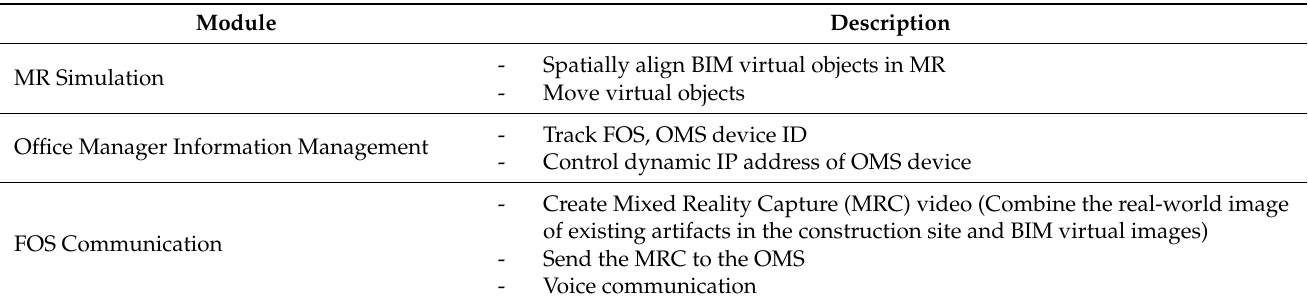
Table 2. Field Operator System modules.